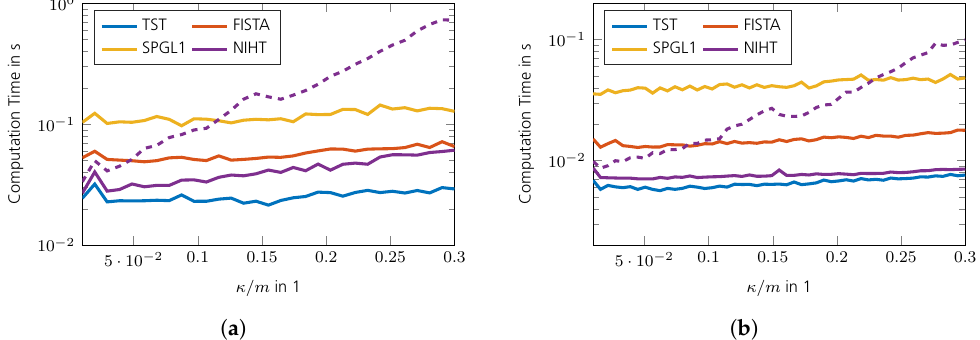
Figure 4. Comparison of computation time m / n = 0.8. The solid line shows NIHT for K = κ and the dashed line K = 2 κ . ( a ) Random sensing operators A ∼ CN ( 0,1 ) . ( b ) DFT sensing operators with random